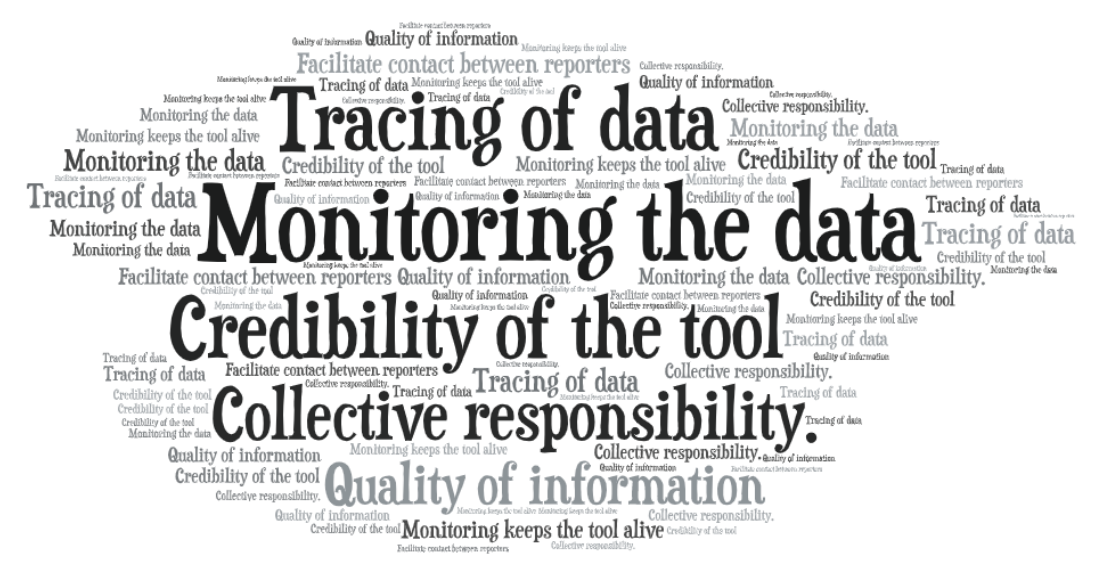
Figure 5. What advantage do you see to monitoring by an administrator? (Open answers). Prepared by authors using unpublished data taken from Google-Form survey forms. Note: Word size is proportional to the frequency.